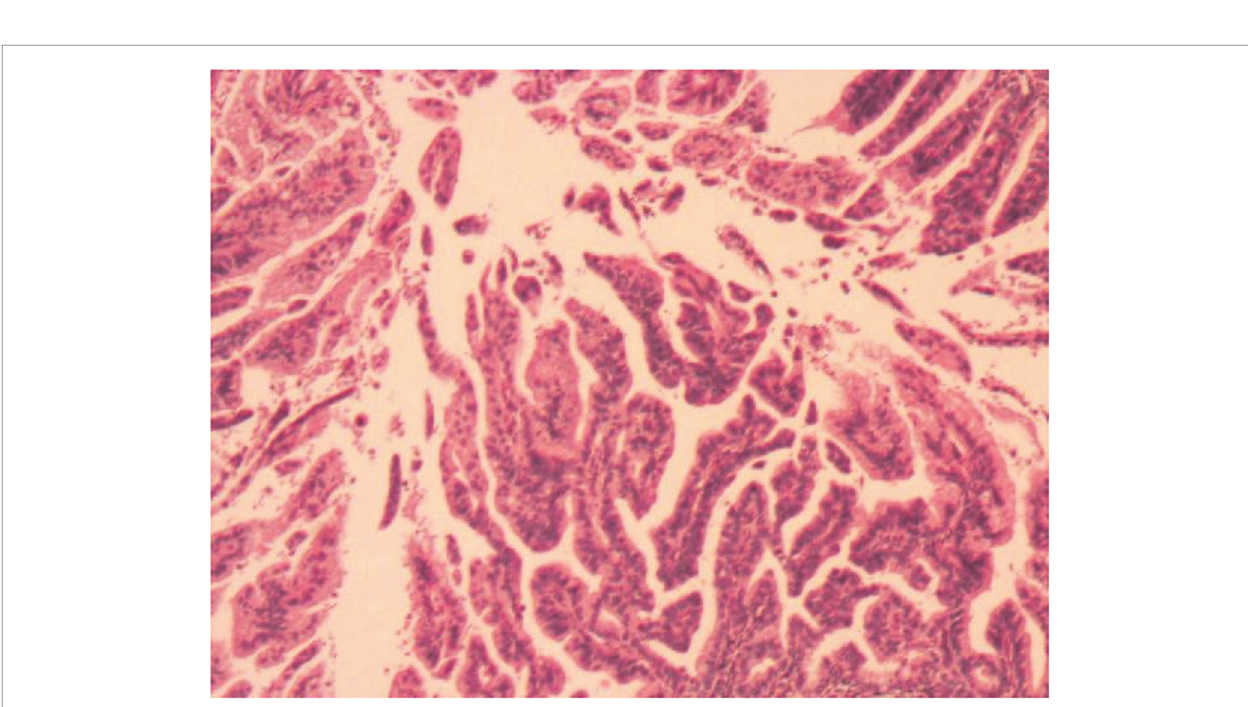
FIGURE 3 | Cervical gastric adenocarcinoma at high magni fi cation. This pathological image shows three characteristics: (1) abundant cytoplasm; (2) Clear boundaries between cells; (3) Typical cystic and tubular glands are